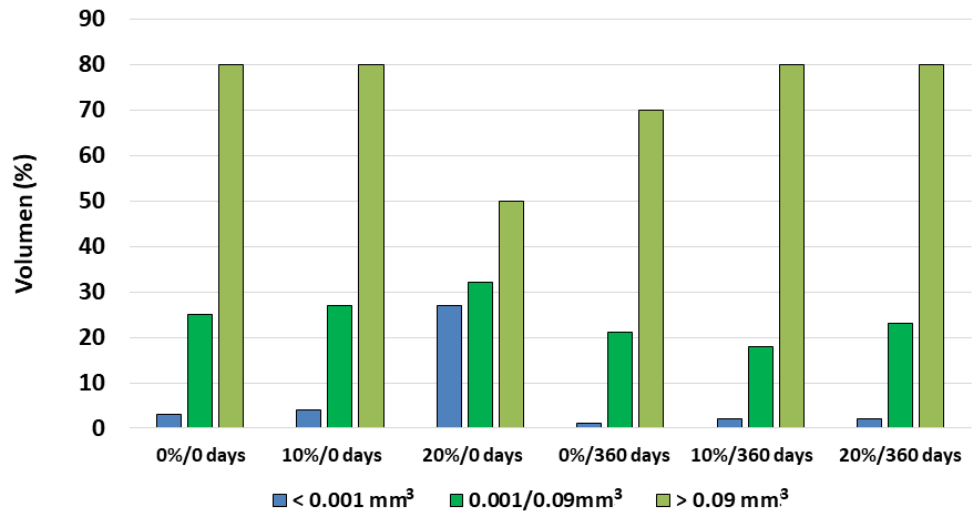
Figure 6. Macroporosity quantification (in % of pore volume) grouped into three pore volume ranges (>0.09 mm 3 , <0.09 mm 3 , >0.001 mm 3 , <0.001 mm 3 ) for PR-1 sample.